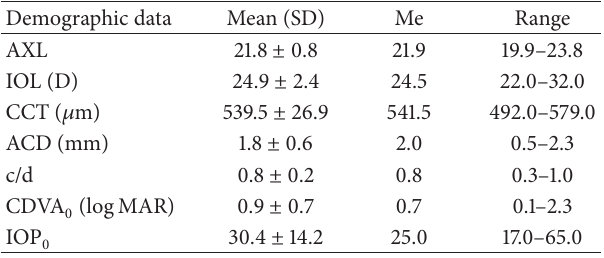
Table 1: Patients’ demographic data.